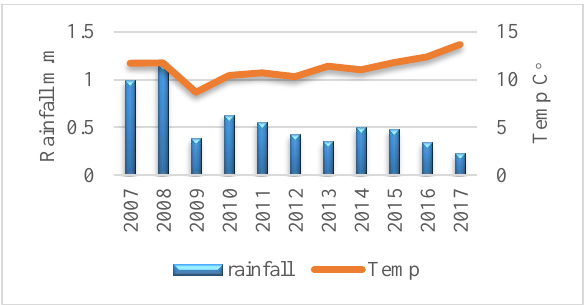
Figure 6: Hunza Station